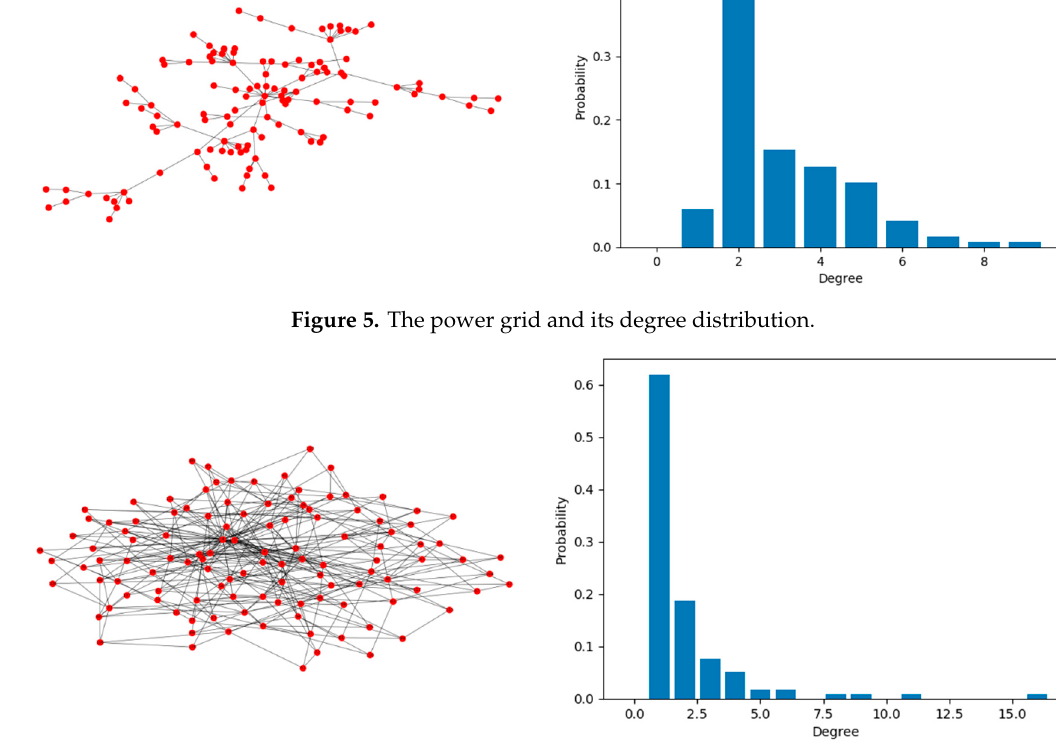
Figure 6. The communication system and its degree distribution. Table 1. The statistical characteristics of the cyber physical power system.